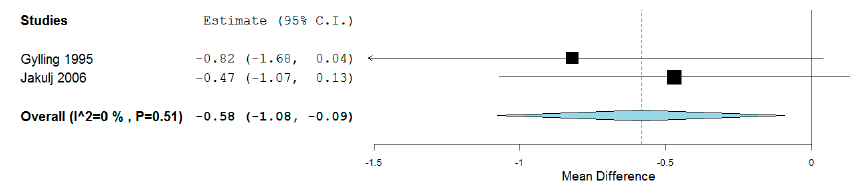
Figure 4. E ff ect of increased intake of plant stanols compared with placebo. Figure 4. Effect of increased intake of plant stanols compared with placebo. Figure 4. Effect of increased intake of plant stanols compared with placebo.